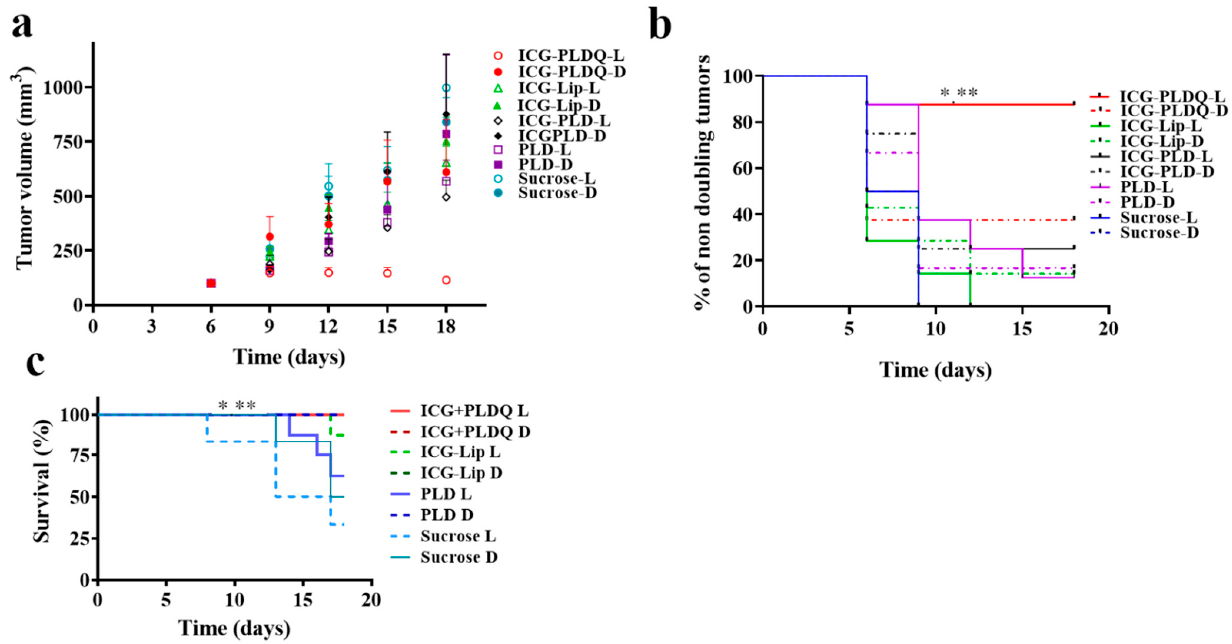
Figure 5. Tumor progression: ( a ). The tumor weight changed as a function of time. Values represent mean ± SE. ( b ). Percent of non-doubling tumors. Long rank test (Mantel Cox) * p < 0.05 compared to PLDQ-D, ICG-PLD D/L, PLD D, ** p < 0.01 compared to Sucrose L, Sucrose D, n = 6–8. ( c ) Survival plot for exclusion of mice from the experiment. Long rank test (Mantel-Cox) ** p < 0.01 significantly different from sucrose L, * p < 0.05 significantly different from sucrose D.